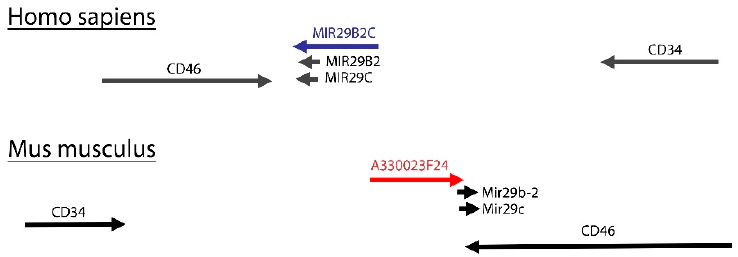
Figure 1. Genomic location of C1orf132 long-noncoding RNA in humans and mice. Top: The genomic location of miR-29b2, miR-29c, and their precursor, MIR29B2CHG , in humans. As shown, the region encoding the lncRNA is located between the CD34 and CD46 genes. Bottom: By searching the genomic location of miR-29 in mice, we found out that the lncRNA A330023F24 is the host gene for miR-29b-2 and miR-29c. Interestingly, the chromosomal location and transcription direction of the lncRNA is conserved between humans and mice.